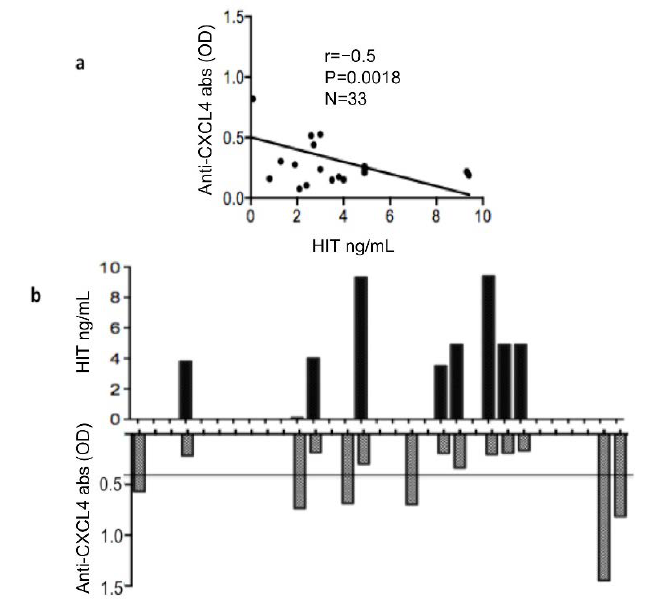
Figure 2. Plasma heparin-dependent antibodies inversely correlate with heparin-independent anti- bodies to CXCL4. OD values of heparin-independent antibodies (anti-CXCL4 abs OD) were plotted against values of heparin-dependent abs (HIT abs) and Spearman’s correlation test was used to address correlation between these antibody types ( a ). The “r” coefficient of correlation, p (signifi- cance) and N (sample size) are reported on the graph. ( b ) Histograms showing the positivity for HIT antibodies and anti-CXCL4 antibodies to show that positivity for anti-CXCL4 and for HIT antibodies are mutually exclusive.